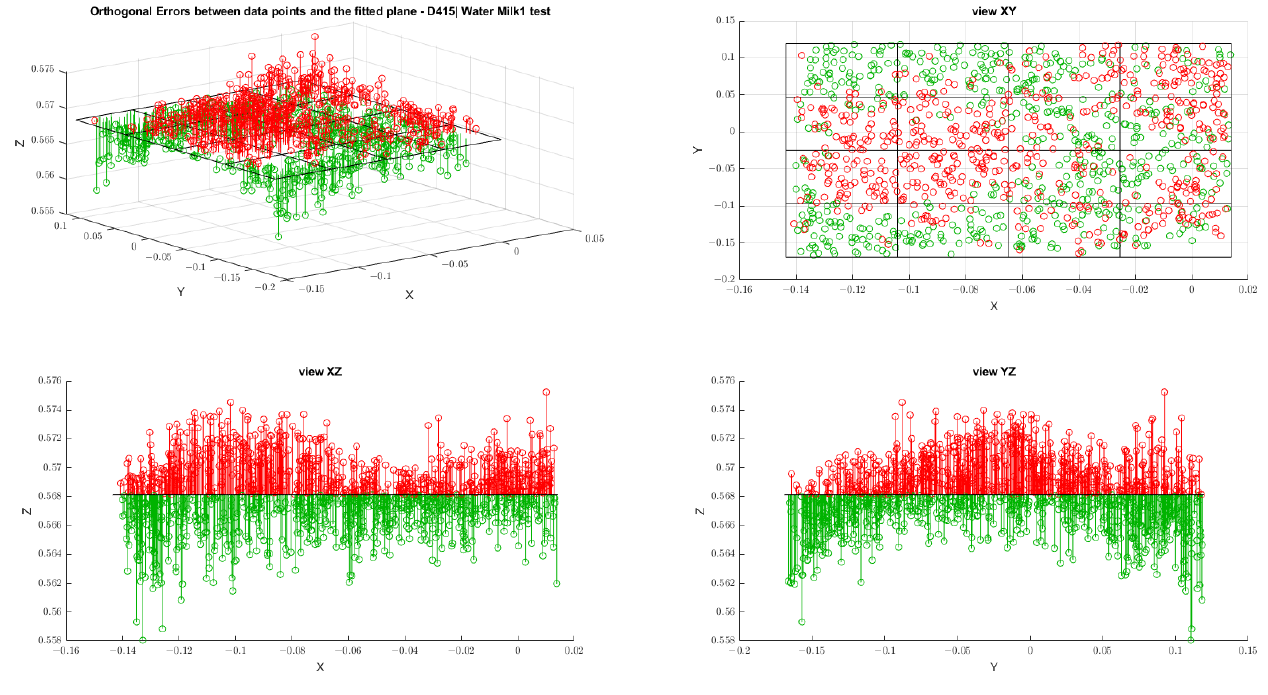
Figure A4. Results of orthogonal errors for the D415 camera referring to the water milk1